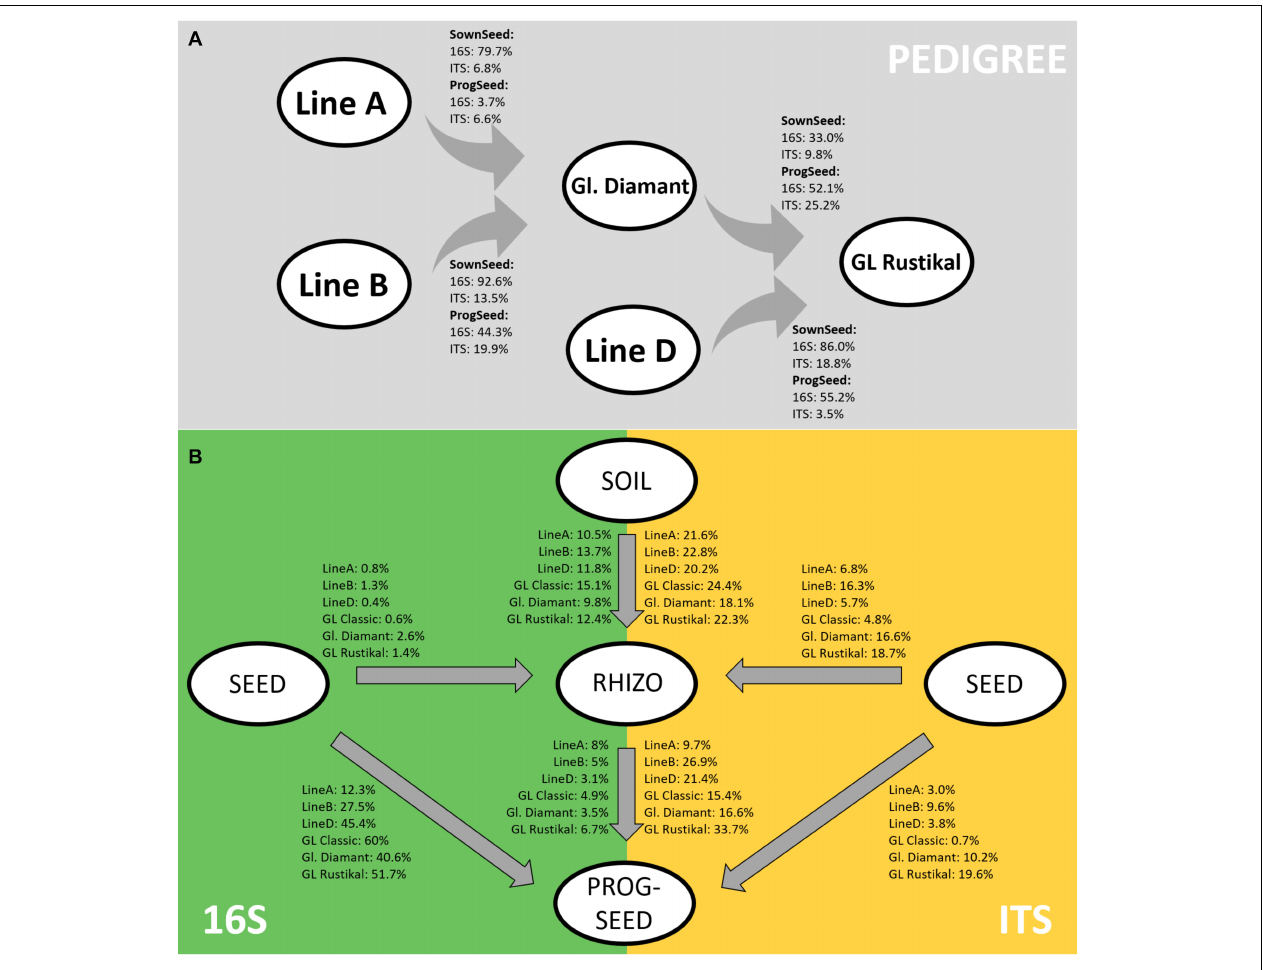
FIGURE 4 | Tracking of bacterial and fungal microbiomes across the pedigree in sown seeds and progeny seeds (A) as well as from sown seeds and soil to rhizosphere and progeny seeds (B) using sourcetracker2. Ident bacterial (16S) and fungal (ITS) traces are indicated as